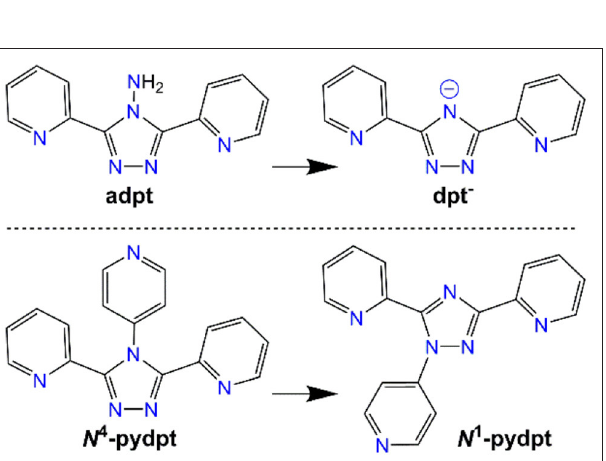
FIGURE 2 | The two Rdpt ligands used in this study, adpt (R = NH 2 ) and N 4 -pydpt (R = 4-pyridyl), and the respective rearrangements (deamination; (White et al., 2012) and N 4 - to N 1 -pyridyl shift; (Kitchen et al., 2010b); see text for more detail), they undergo during complexation, resulting in complexes of dpt − and N 1 -pydpt.